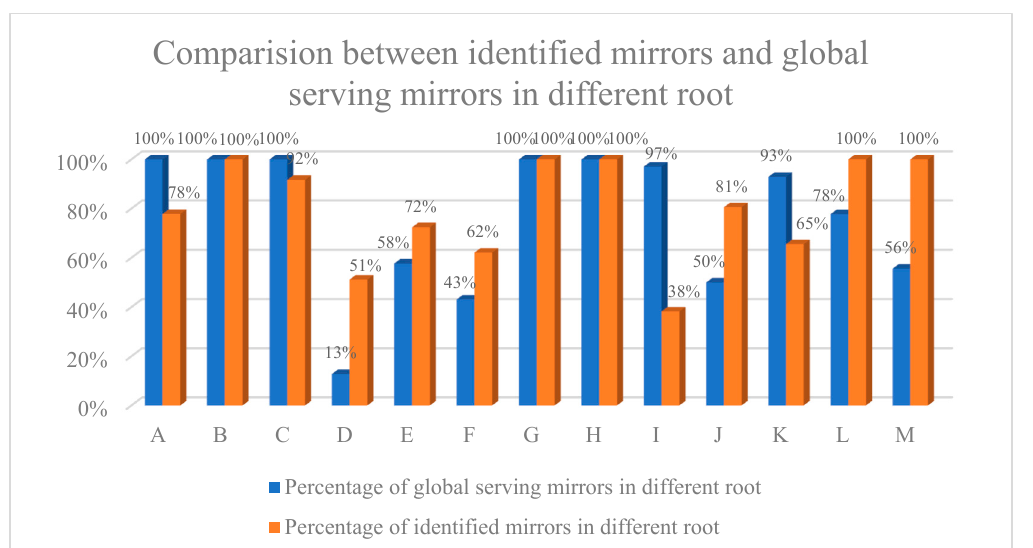
Figure 5. The percentage for each root’s identified mirrors and global serving mirrors. The global serving mirrors are easier to be probed and identify.